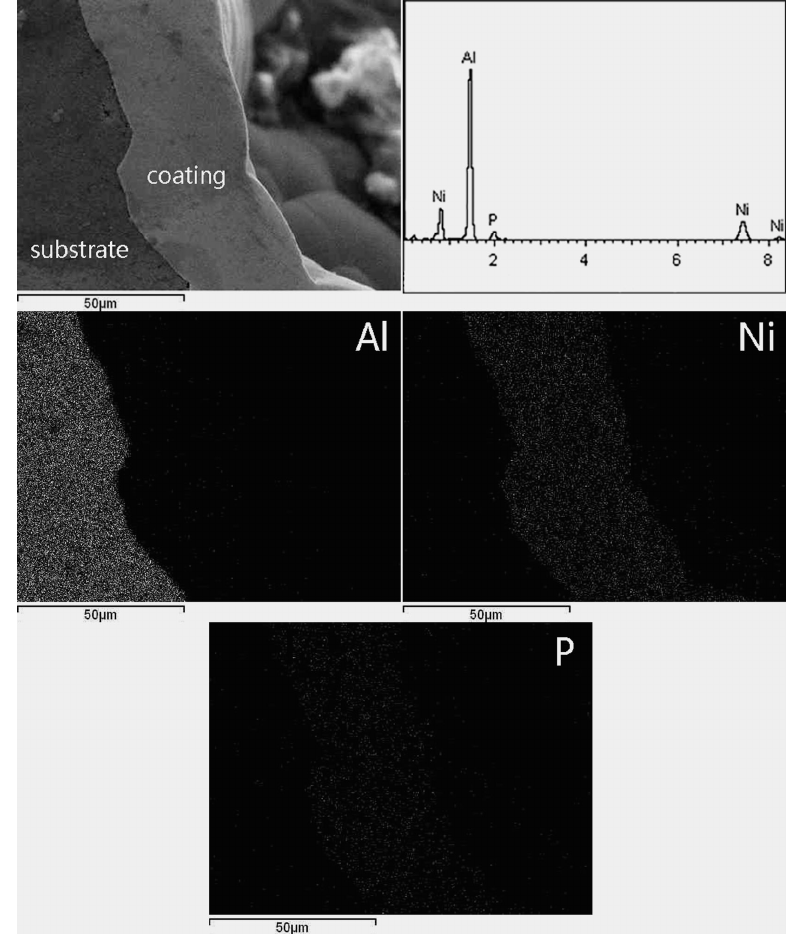
Figure 6. The element distribution of EN coating.